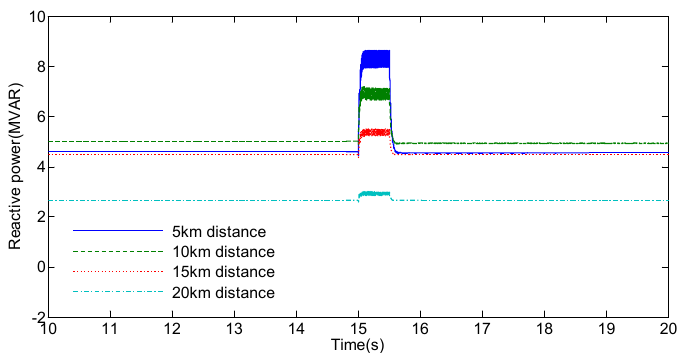
Figure 11. The reactive power of grid system under different connection distance between the grid source and the DFIG.